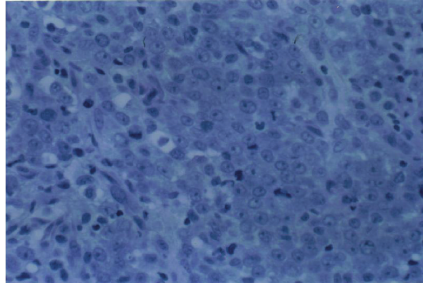
Figure 3: Trucut biopsy of the mass. Moderate-to-large size neo- plastic cells with slightly irregular nuclei and conspicuous nucleoli.